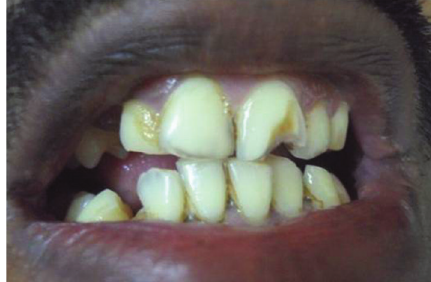
Figure 2: Crowding and traumatic occlusion.